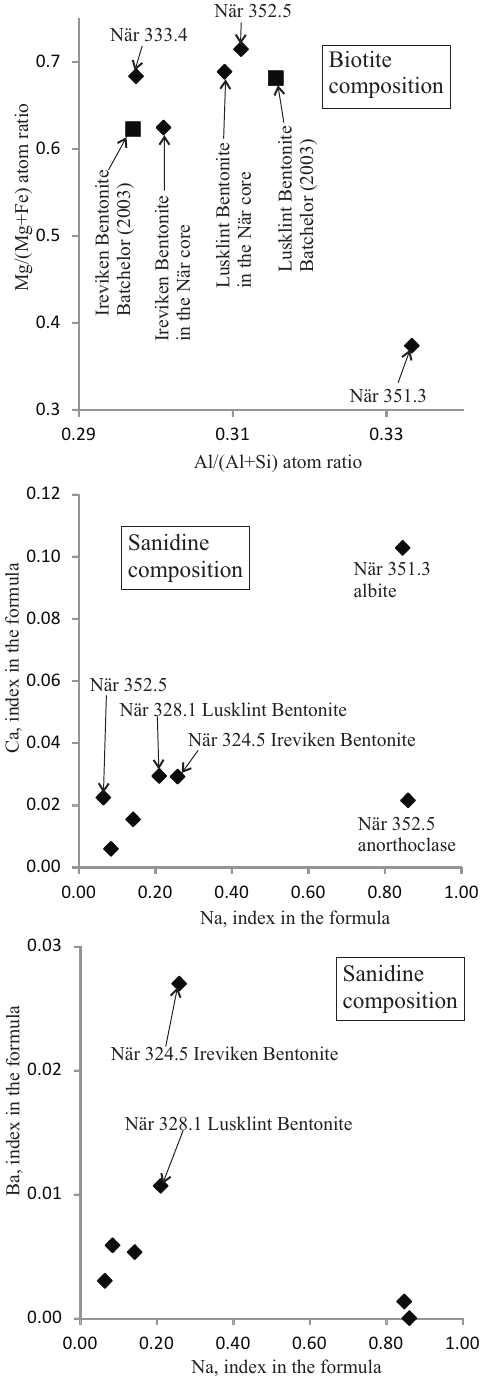
Fig. 4. Composition of biotite and sanidine phenocrysts according to the EDS